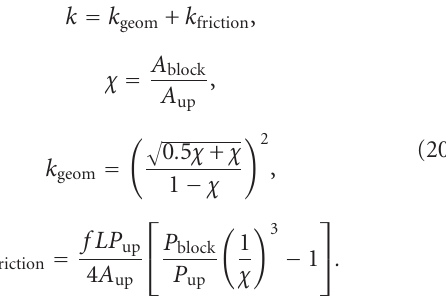
Figure 5: Predicted outlet fluid temperature for Case 01-3233 with A OBS = 3 . 3 (a) and A OBS = 49 . 5 (b). Shaded rods operate at 4 times the power of the unshaded rods.